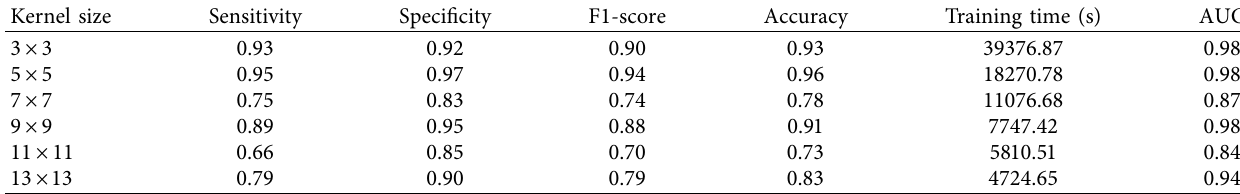
Table 9: Test results for Swarm behaviour